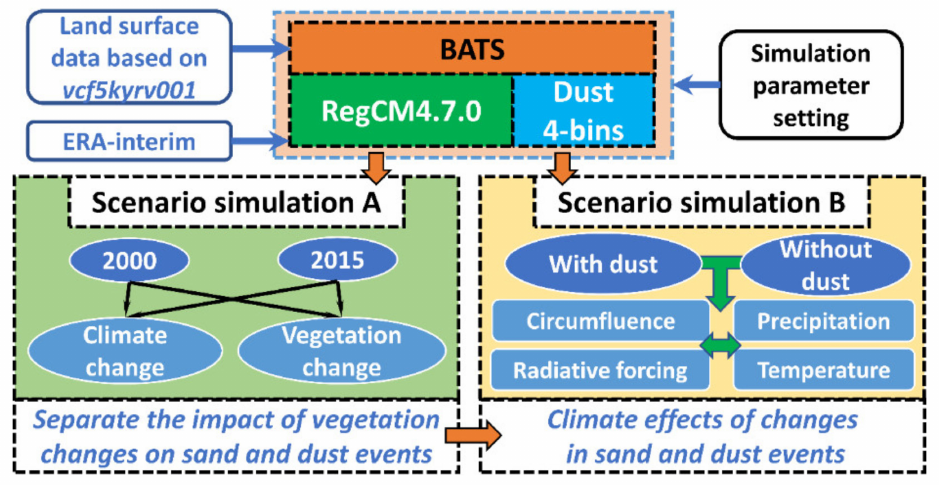
Figure 2. Analysis